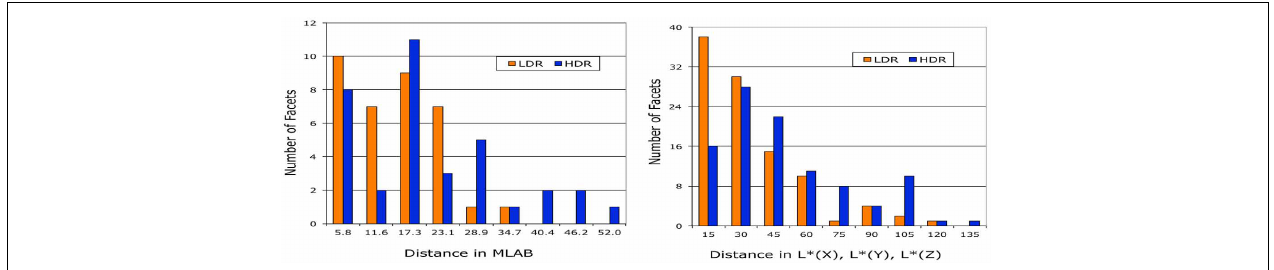
FIGURE 12 | Comparison of the distributions of LDR and HDR distances from ground truth observed in magnitude estimation and watercolor reflectance experiments.